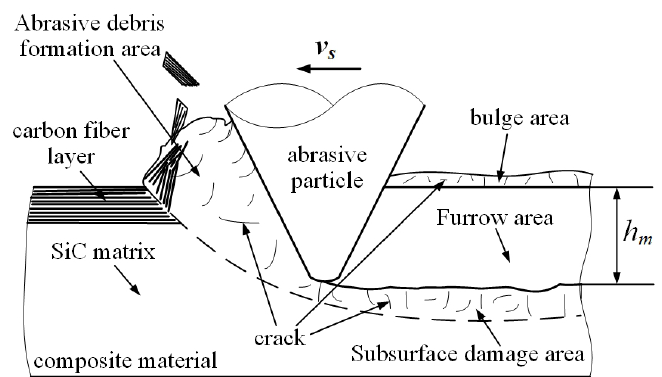
Figure 16. Two-dimensional cutting model of single abrasive particle for C/SiC